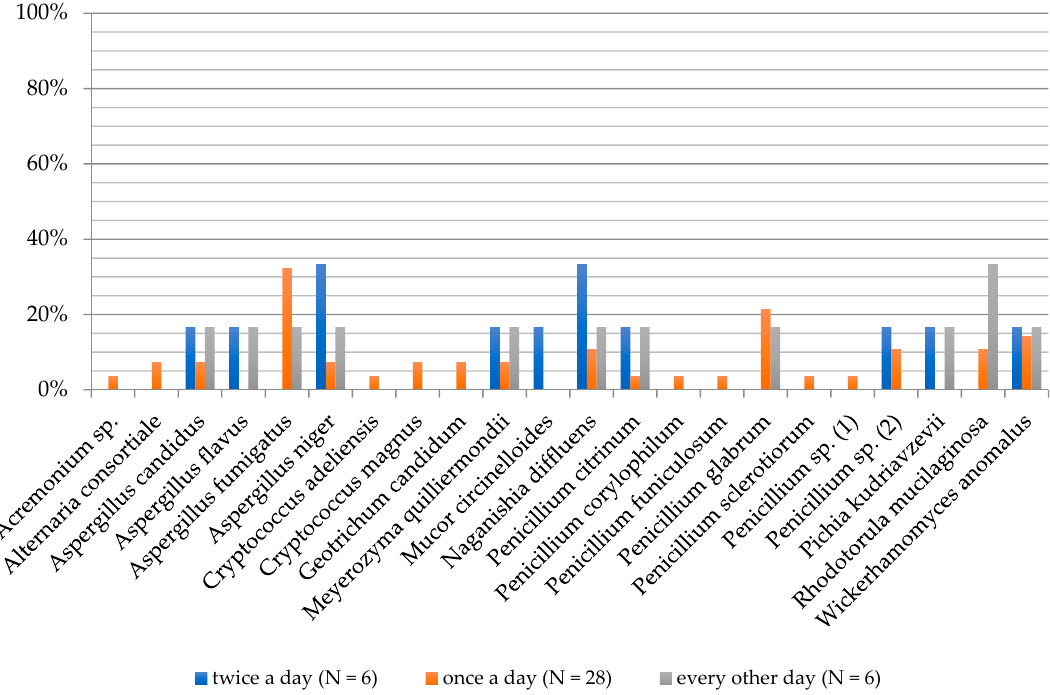
Figure 6. Frequency of the occurrence of fungi on the foot skin depending on the washing feet frequency of examined people.